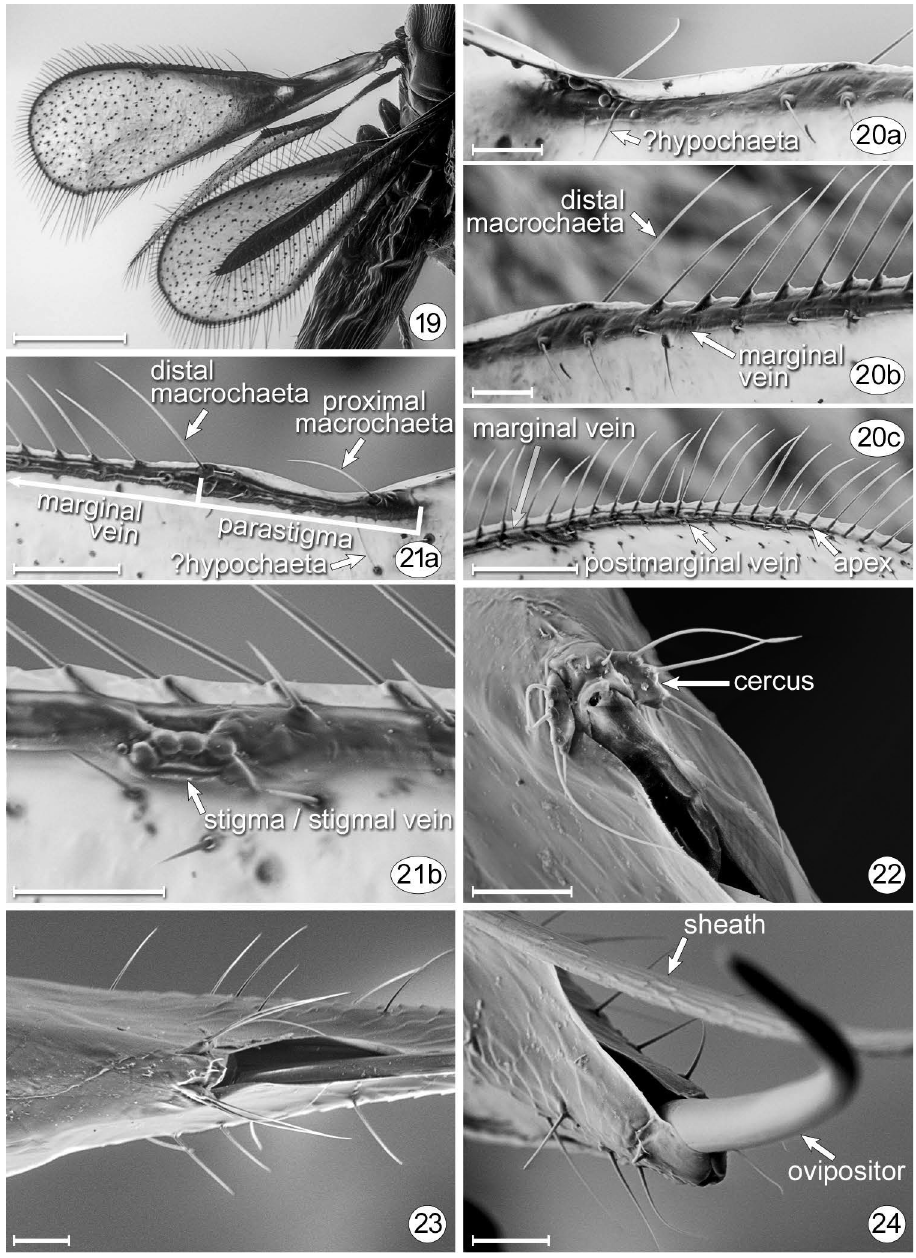
Figures 19–24. Eustochomorpha haeckeli , female. 19 wings 20a parastigma, ventral 20b base of mar- ginal vein, ventral 20c apex of marginal vein, stigma + postmarginal vein, ventral 21a parastigma, dorsal 21b stigma, dorsal 22 gaster apex showing cerci, posterolaterodorsal 23 gaster apex showing cerci, dorsal 24 gaster apex, posterolaterodorsal. Scale bar for 19 = 200 μm; 20a, 20b, 21b, 22–24 = 20 μm; 20c, 21a = 50